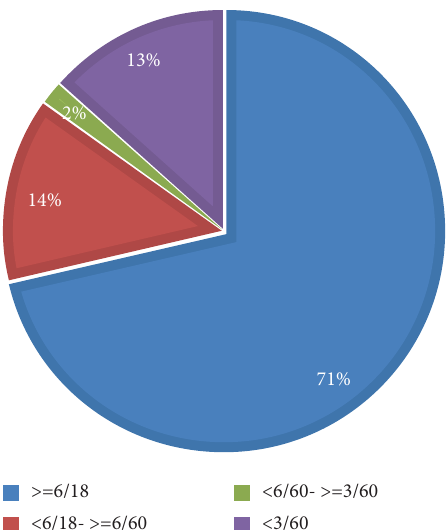
Figure 2: Visual acuity result of best eye in South Ari district, Southern Ethiopia, in December 2021.